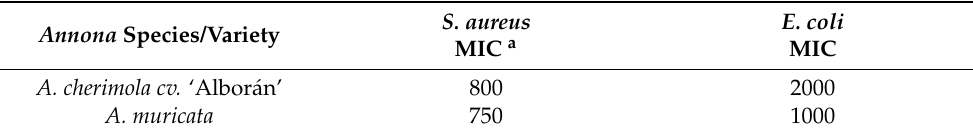
Table 3. Antibacterial activity of the Annona leaves extracts obtained from A. cherimola cv. ‘Albor á n’ and A. muricata using CO 2 + 50%